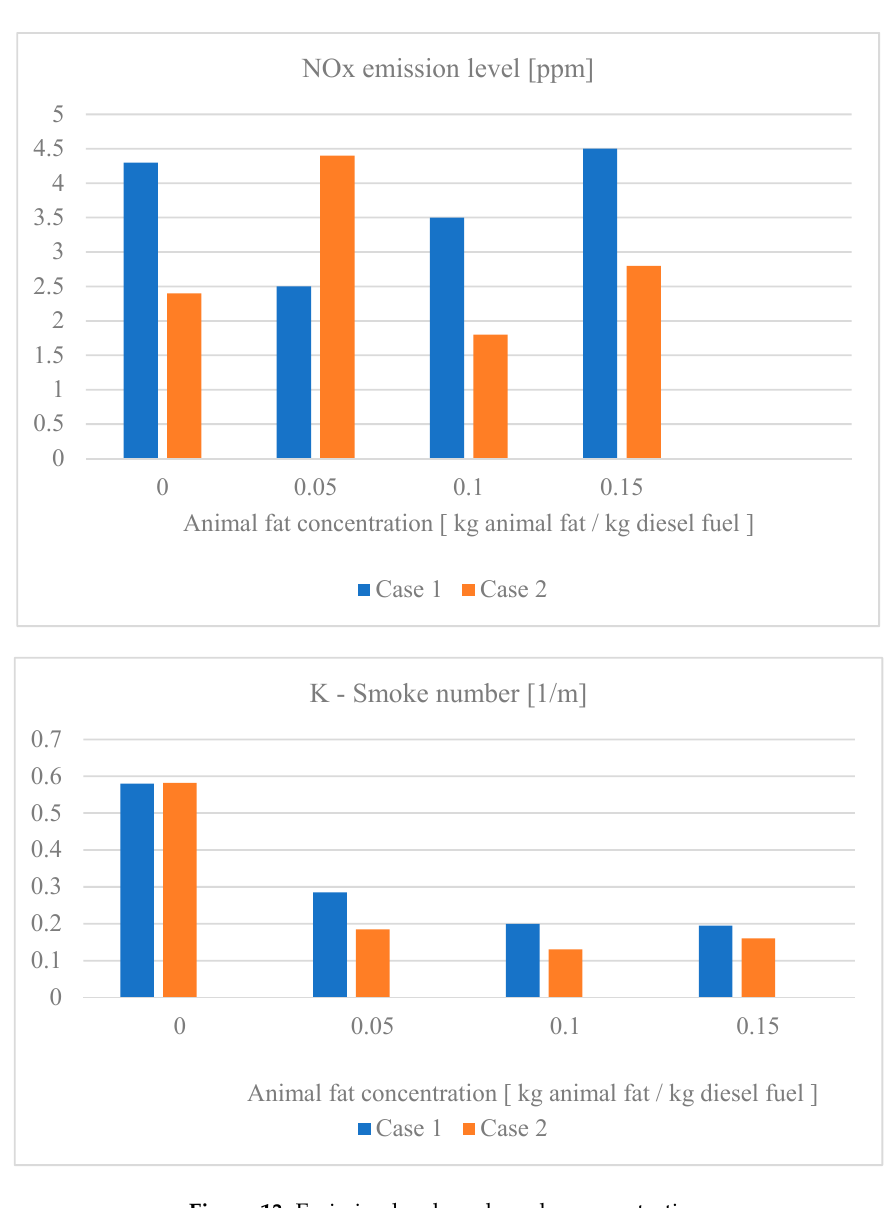
Figure 13. Emission levels and smoke concentration. Energies 2018 , 11 , x FOR PEER REVIEW